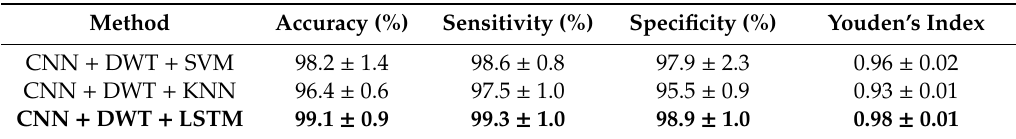
Table 3. Classification of 1 × 4096 feature vector of liver tumors obtained from CNN with SVM, KNN, and